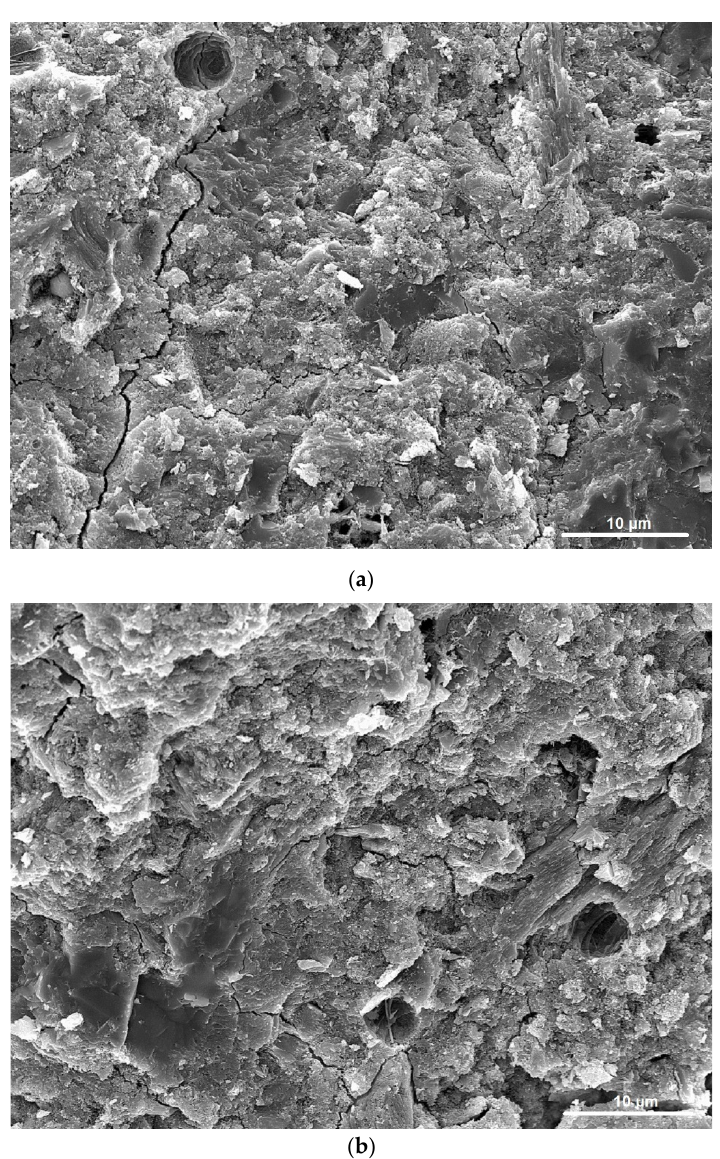
Figure 5. ( a ). Sample microstructure of cement slurry containing 1% n-SiO 2 . Magnification 1000×. ( b ). Sample microstructure of cement slurry containing 1% n-SiO 2 . Magnification 1000 ×